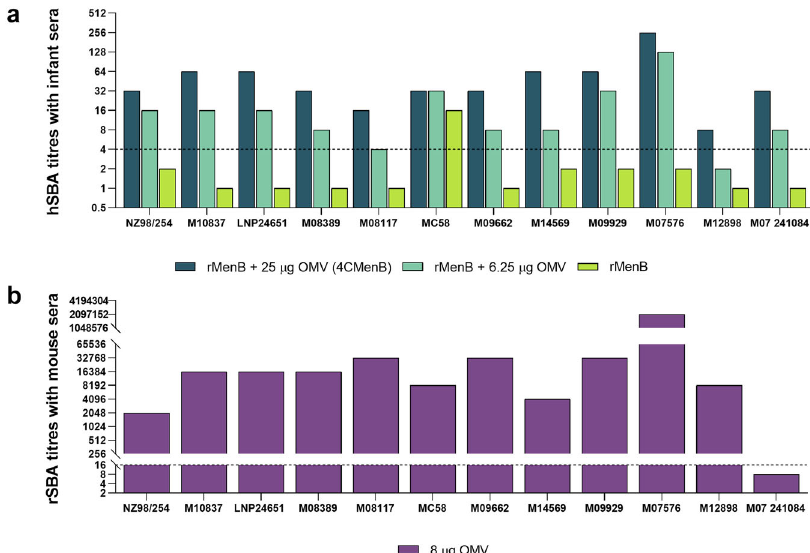
Fig. 1 The OMV component of 4CMenB mediated bactericidal responses on vaccine heterologous strains. a Infant sera were collected and pooled (25 subjects each group) after the fourth vaccination dose and they were assayed in SBA with human complement. Solid bars indicate hSBA titers obtained against the 12 MenB strains using post-immunization rMenB + OMV (dark green), rMenB + 1/4 OMV (light green), rMenB (yellow-green) antisera. Bactericidal titers of preimmune sera were <2 for all groups against all tested strains. Titers ≥ 4 (dashed line) are considered protective. b rSBA titers were obtained using anti-OMV mouse sera against the panel of 12 MenB strains under investigation. Eleven groups of eight mice each deriving from distinct immunization schemes were pooled ( n = 88) and used in the analysis. Serum bactericidal titers, indicating the dilution of the pooled mouse sera at which 50% of killing is reached, were determined using rabbit complement as source of complement. Titers ≥ 16 (dashed line) are considered positive as this dilution represents a fourfold increase respect to the lower limit of the assay corresponding to the fi rst dilution tested